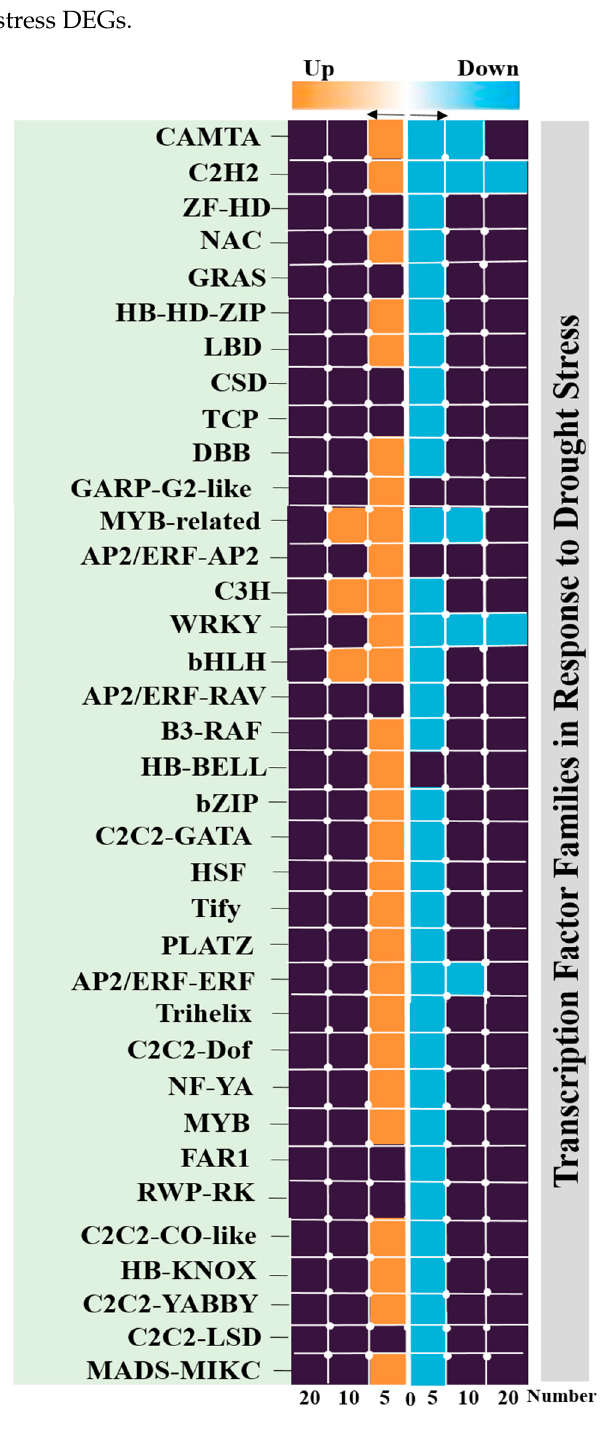
Figure 6. Bar plot showing the distribution of TF families identified in DEGs. The numbers of up- and downregulated genes in TF families. The y-axis refers to the number of genes, while the x-axis shows TF